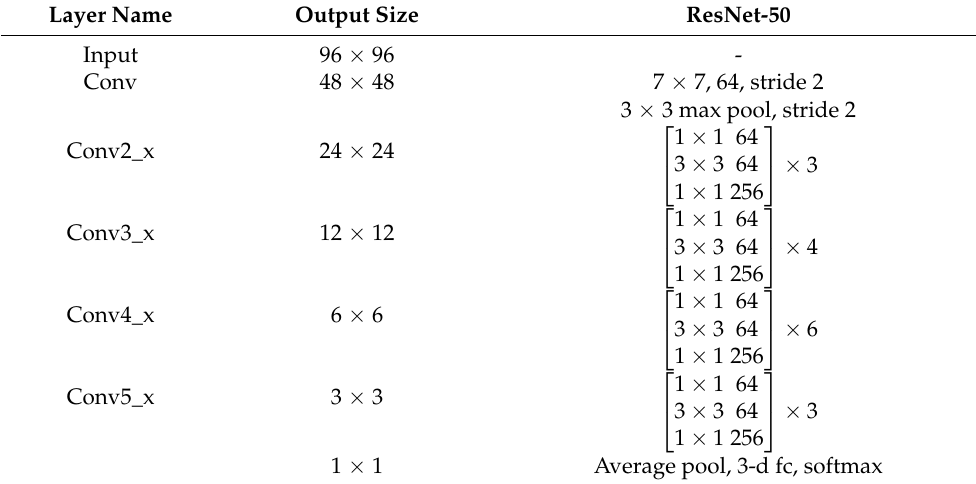
Table 3. ResNet-50 network structure.